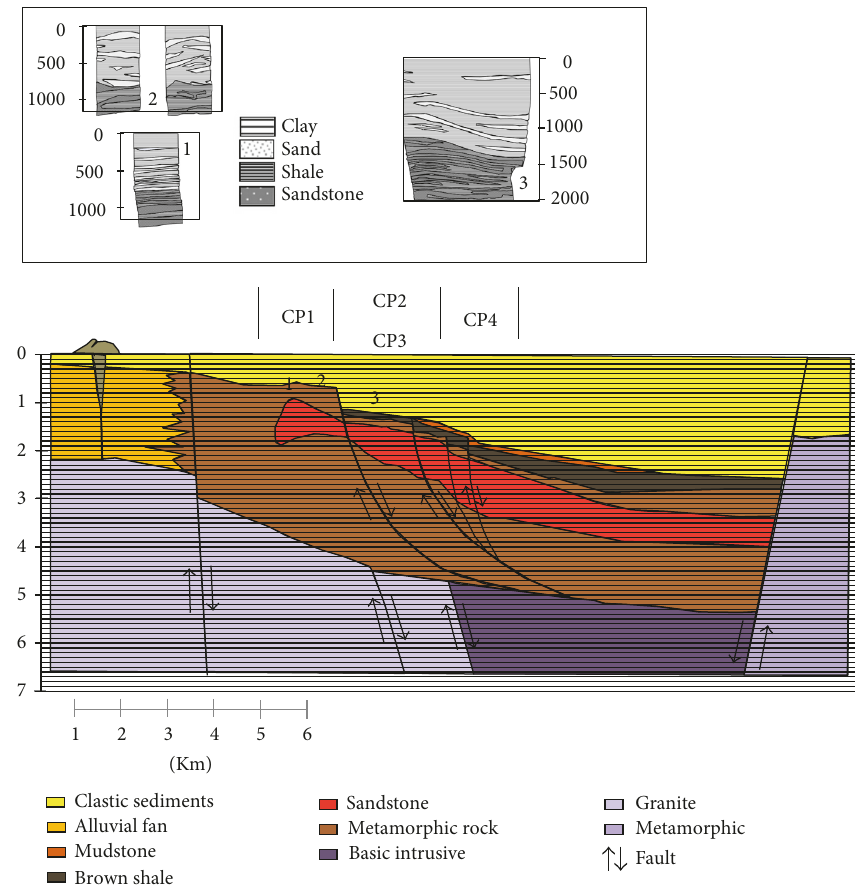
Figure 7: CP geology cross section. Stratigraphic column was modified from Lira [21] and Pe˜na et al.